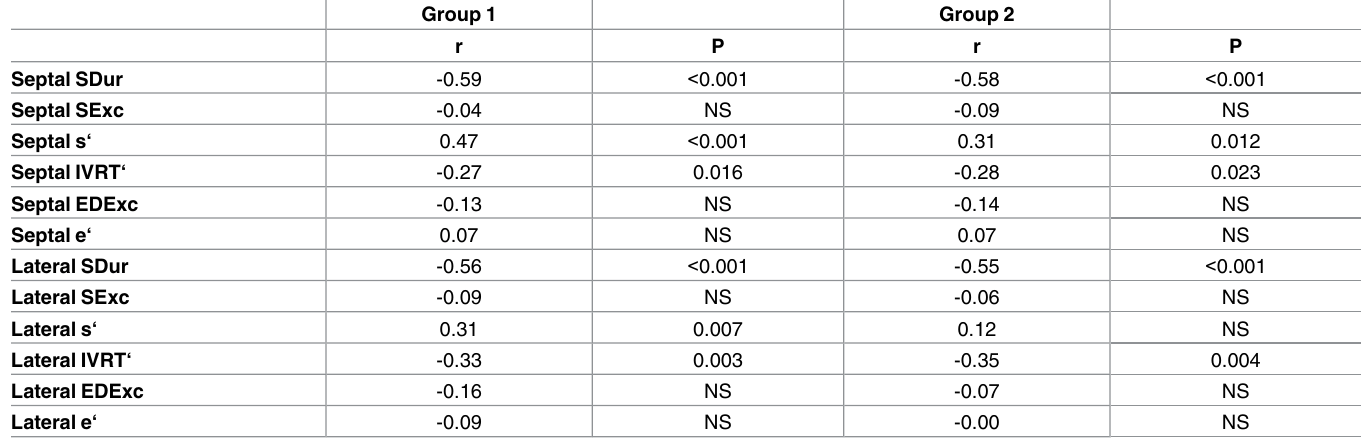
Table 3. Univariate correlations of heart rate in Group 1 and Group